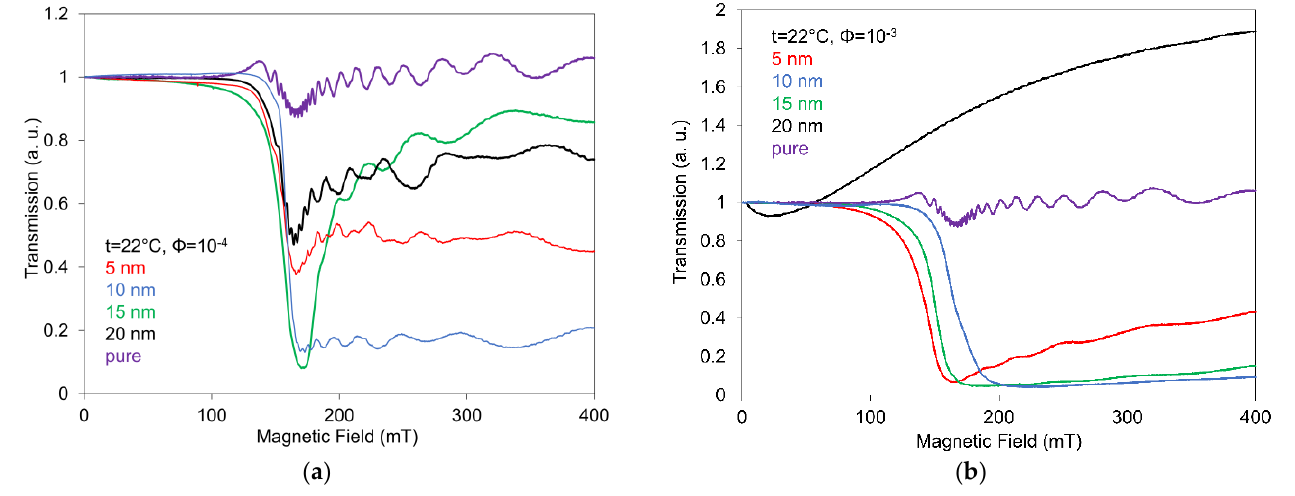
Figure 4. Dependences of light transmission on a magnetic field for 6CB liquid crystal doped with spherical magnetic nanoparticles with size 5 nm, 10 nm, 15 nm and 20 nm for the concentrations 10 − 4 ( a ) and concentration 10 −3 ( b ), including pure 6CB.